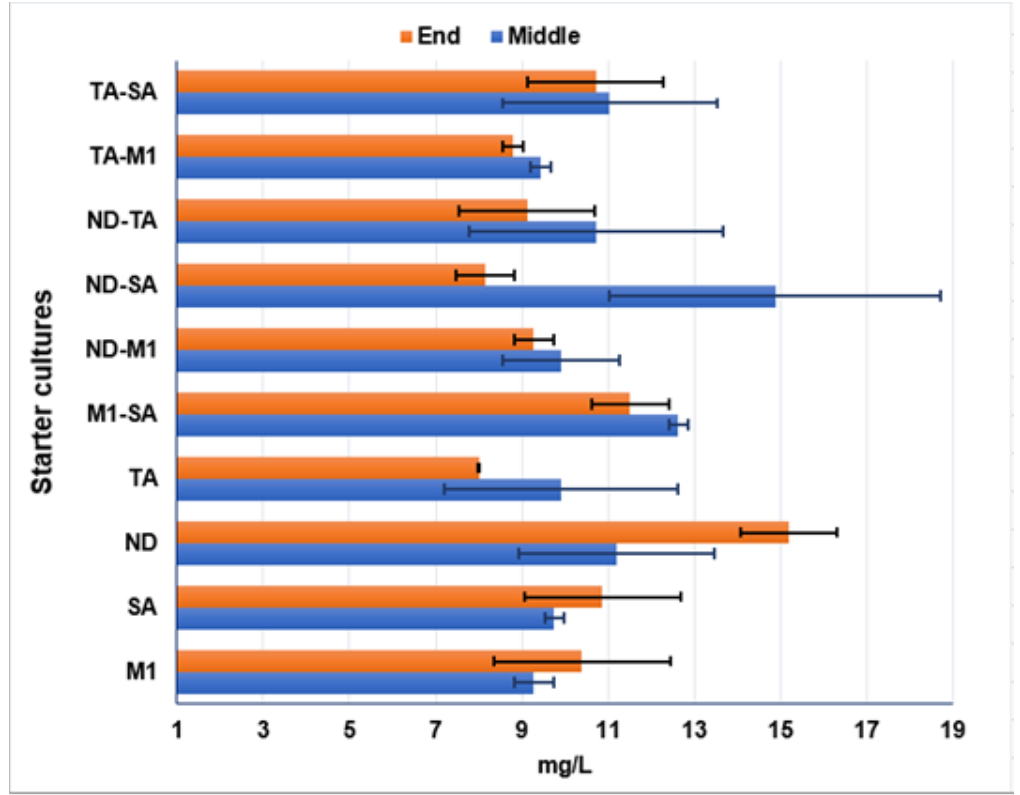
Figure 3. Free SO 2 content (mg / L) in the samples obtained by single and mixed starters determined at middle and end phase of the fermentation process. See Table 2 for the results obtained by ANOVA analysis.